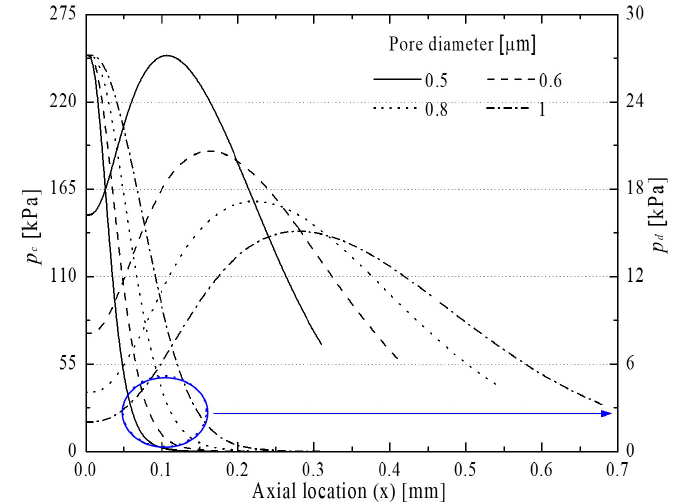
Figure 8. Values of pressures p c and p d as functions of axial location for different pore diameters.